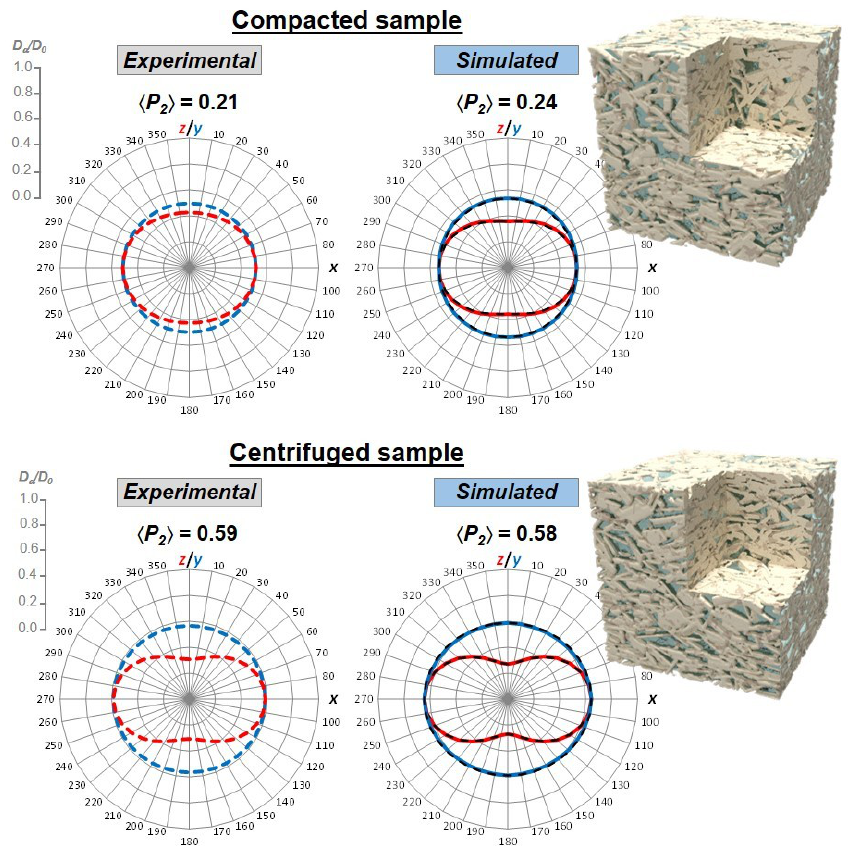
Figure 18. Components of the water self-diffusion tensor measured by 1 H NMR PGSE attenuation within compressed and centrifugated kaolinite clay samples. Numerical simulations of Brownian Dynamics are used to simulate the water self-diffusion tensor within virtual porous media, shown as inserts, mimicking these clay samples (see text). Reprinted from Ref. [52]. Copyright (2020), with permission from Elsevier.